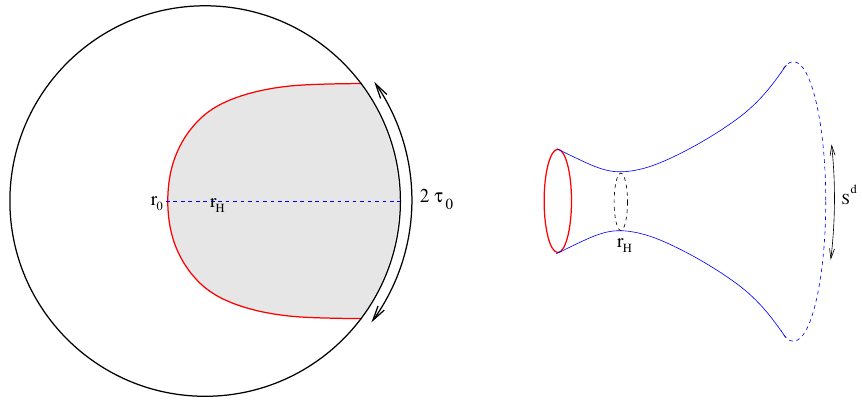
Figure 8 . Euclidean geometry associated with a T > 0 state. Left: ETW brane trajectory on r; (cid:28) plane, with r = r H at the center and r = 1 represented as the boundary of the disk. We have a S d of radius r associated with each point. Right: spatial geometry (cid:12)xed by time-re(cid:13)ection symmetry (blue dashed line on the left). This provides the initial data for the Lorentzian